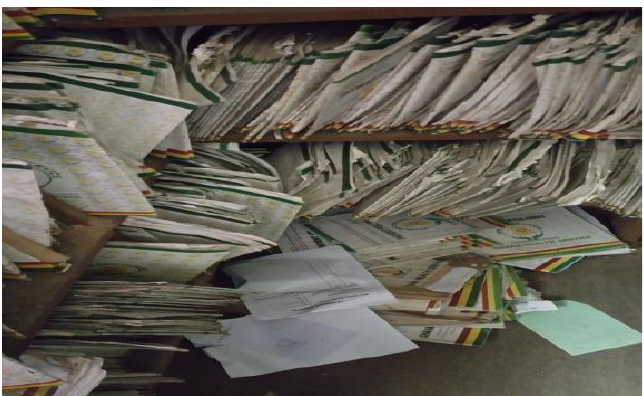
Figure 1. Sample patient files in a records